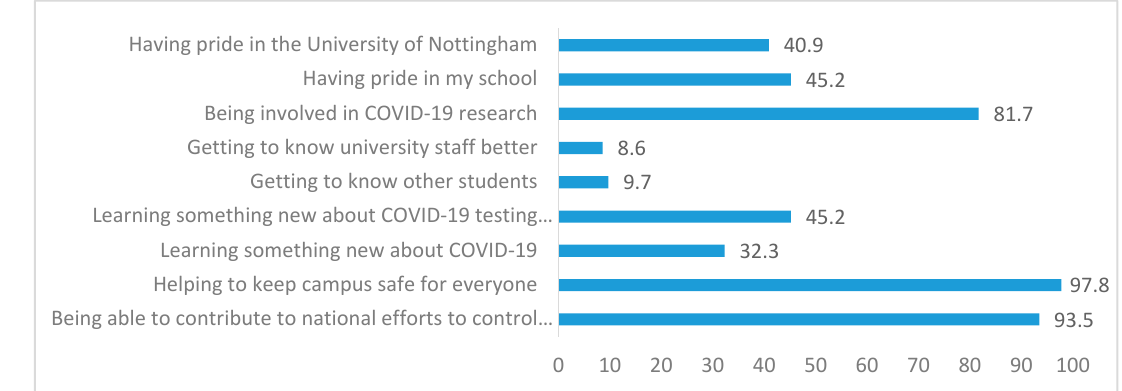
Figure 1. Perceived benefits of university testing service ( n = 99, % yes).